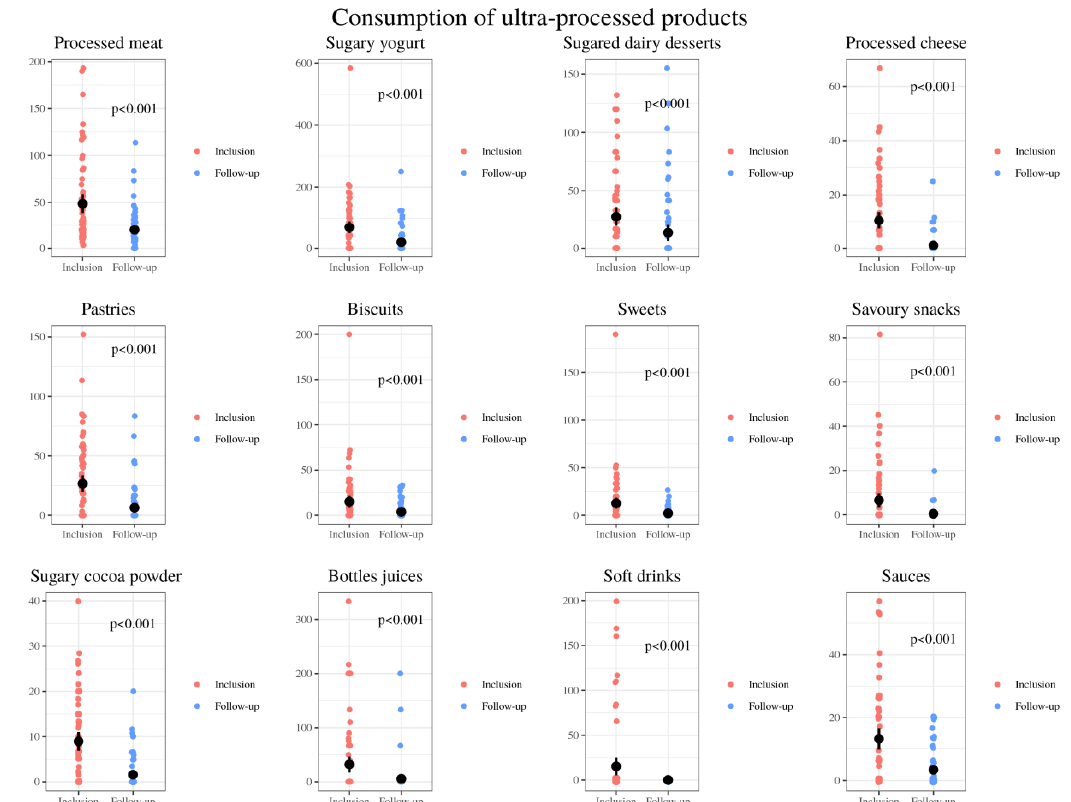
Figure 5. Comparison of the relative consumption of ultra-processed products: grams of processed meat, sugary yogurt, sugared dairy desserts, processed cheese, pastries, biscuits, sweets, savory snacks, sugary cocoa powder, bottles juices, soft drinks and sauces per day consumed by 72 CD pediatric individuals at baseline (inclusion) and after nutrition intervention (follow-up).